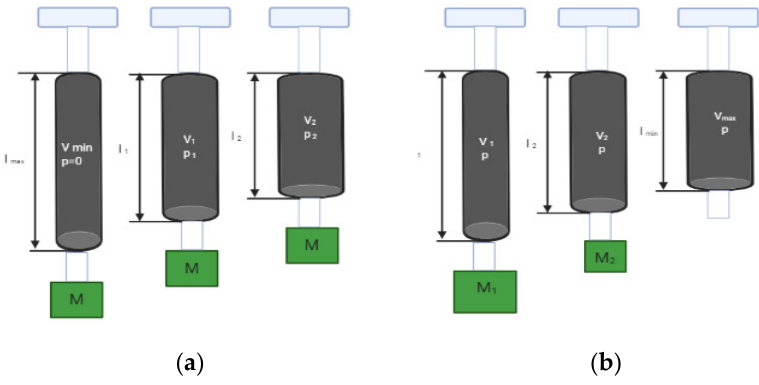
Figure 3. Operating mode at ( a ) constant load ( M ); ( b ) constant pressure ( p ).